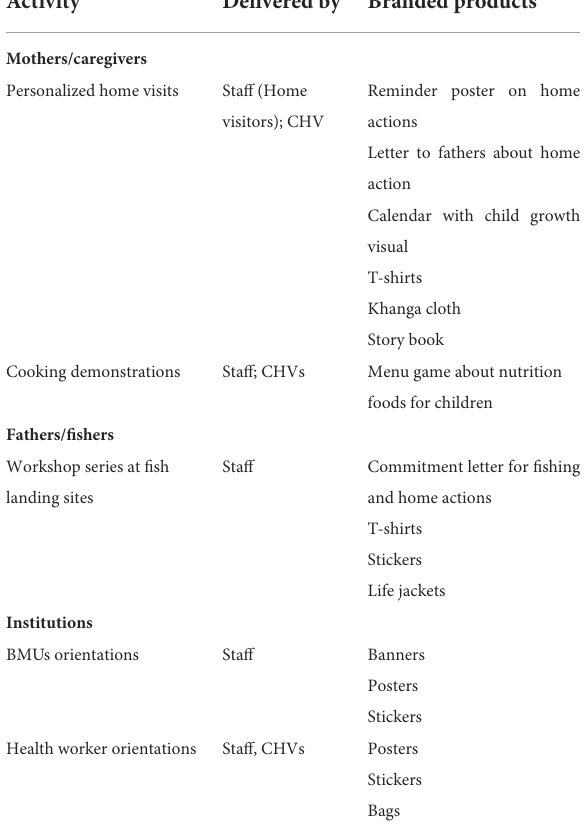
TABLE 3 Social marketing campaign activities and